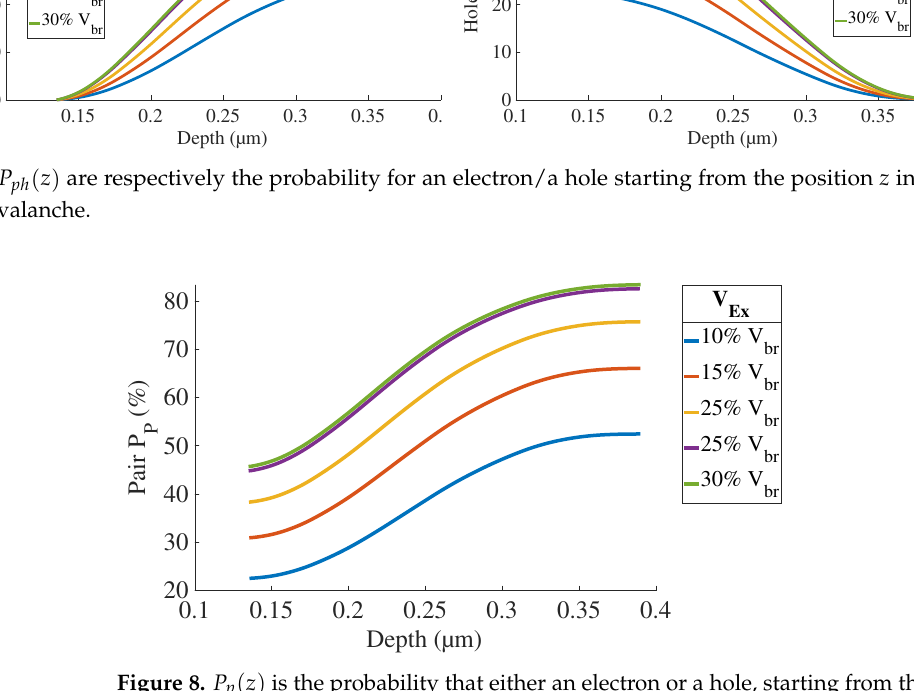
Figure 8. P p ( z ) is the probability that either an electron or a hole, starting from the position z inside the depletion region, triggers an avalanche